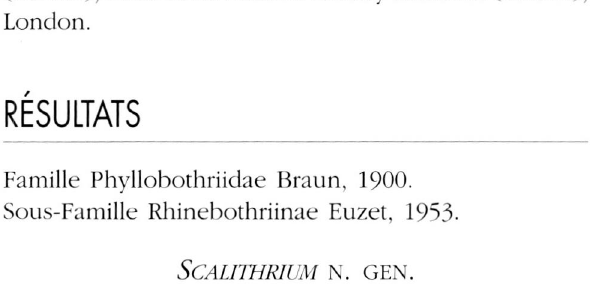
(figure 2). Nous donnons, à partir d'une redescription de l'espèce-type Scalithrium minimum (Van Beneden,